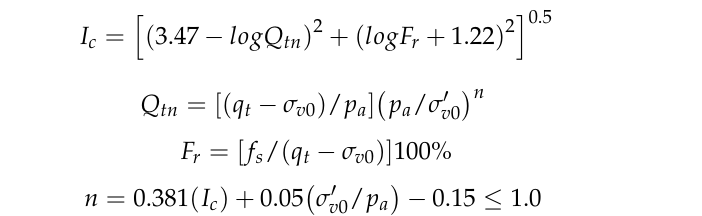
Figure 8. SPT-based and CPT-based friction angles and relative density in the gneiss layer [41–44].